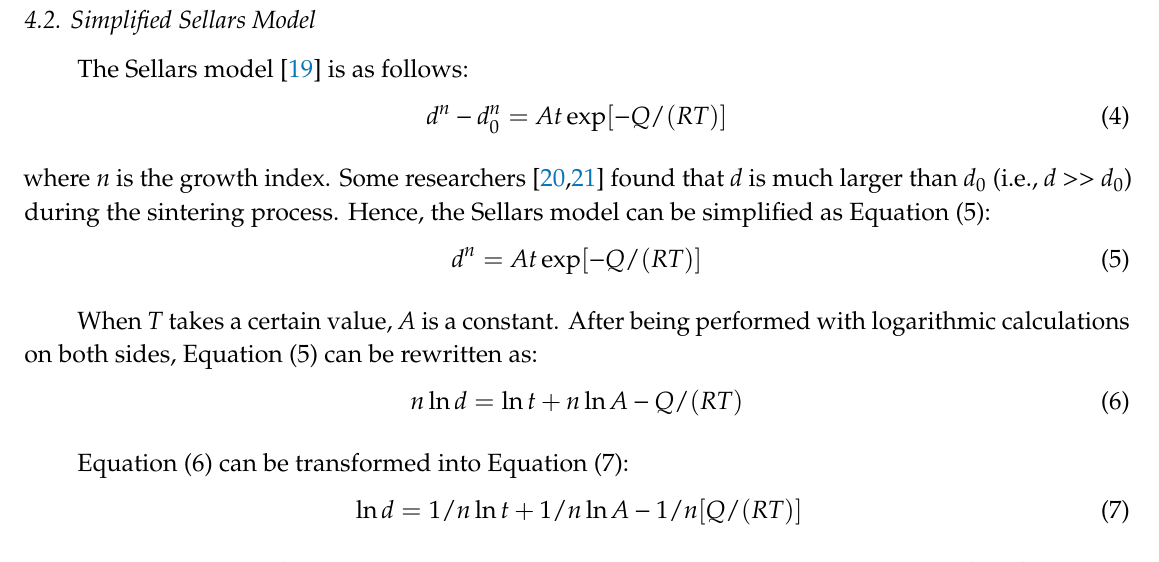
) and 1/ T of the 0.65CLT-0.35SMT ceramics. 0